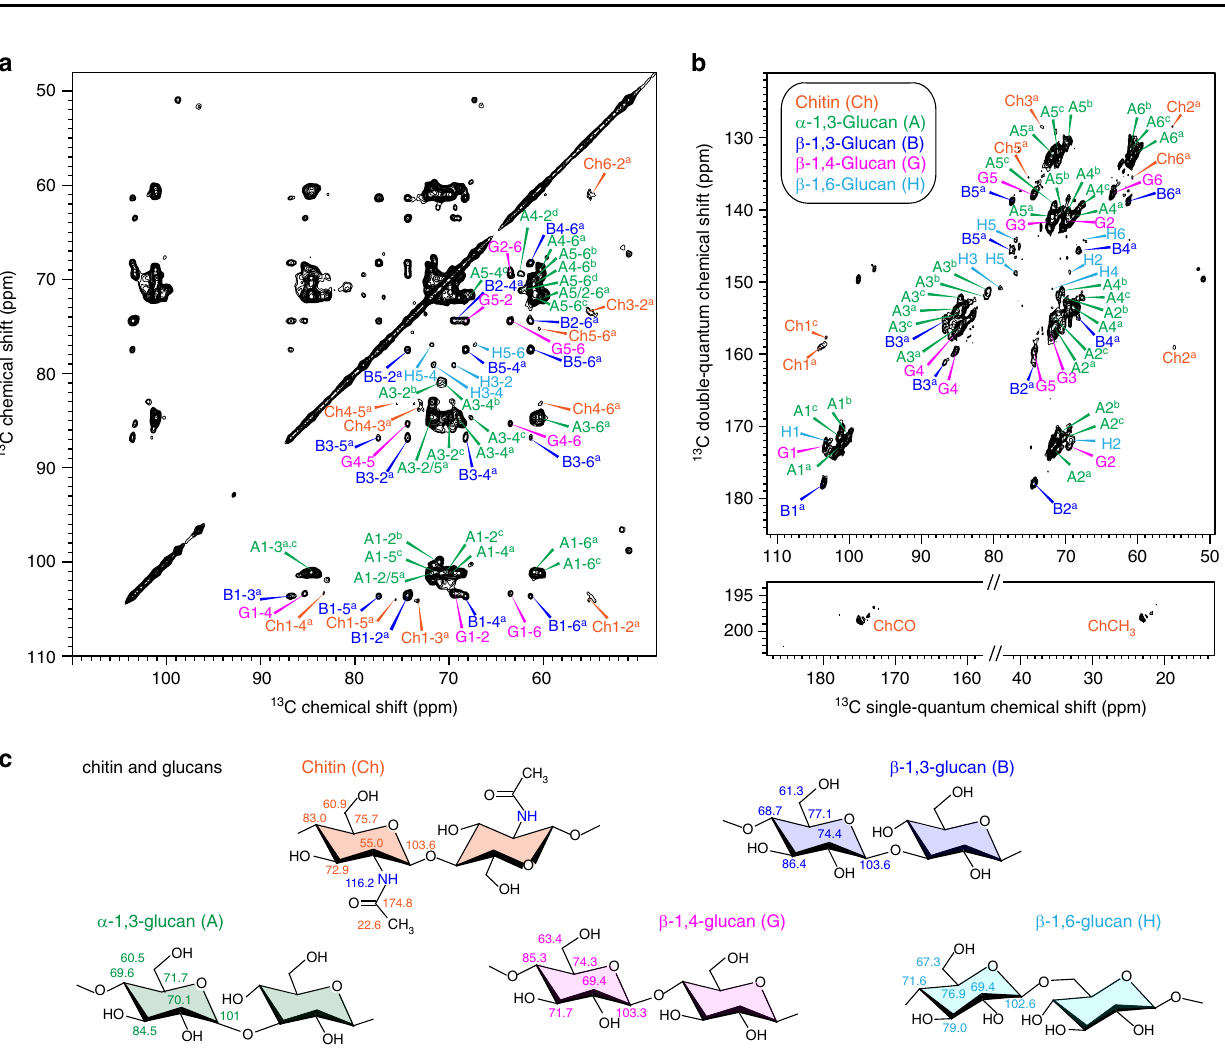
Fig. 1 Chitin and glucans form the rigid domain of intact A. fumigatus cell walls. a 2D 13 C – 13 C correlation spectrum measured with 53-ms CORD mixing detects all intramolecular cross peaks of chitin and four types of glucans. Abbreviations are used for resonance assignment and different polysaccharide signals are color coded. b 13 C CP J-INADEQUATE spectrum resolves the 13 C through-bond connectivity for each polysaccharide. c Identi fi ed polysaccharides and representative chemical shifts. All spectra were measured on an 800 MHz solid-state NMR spectrometer